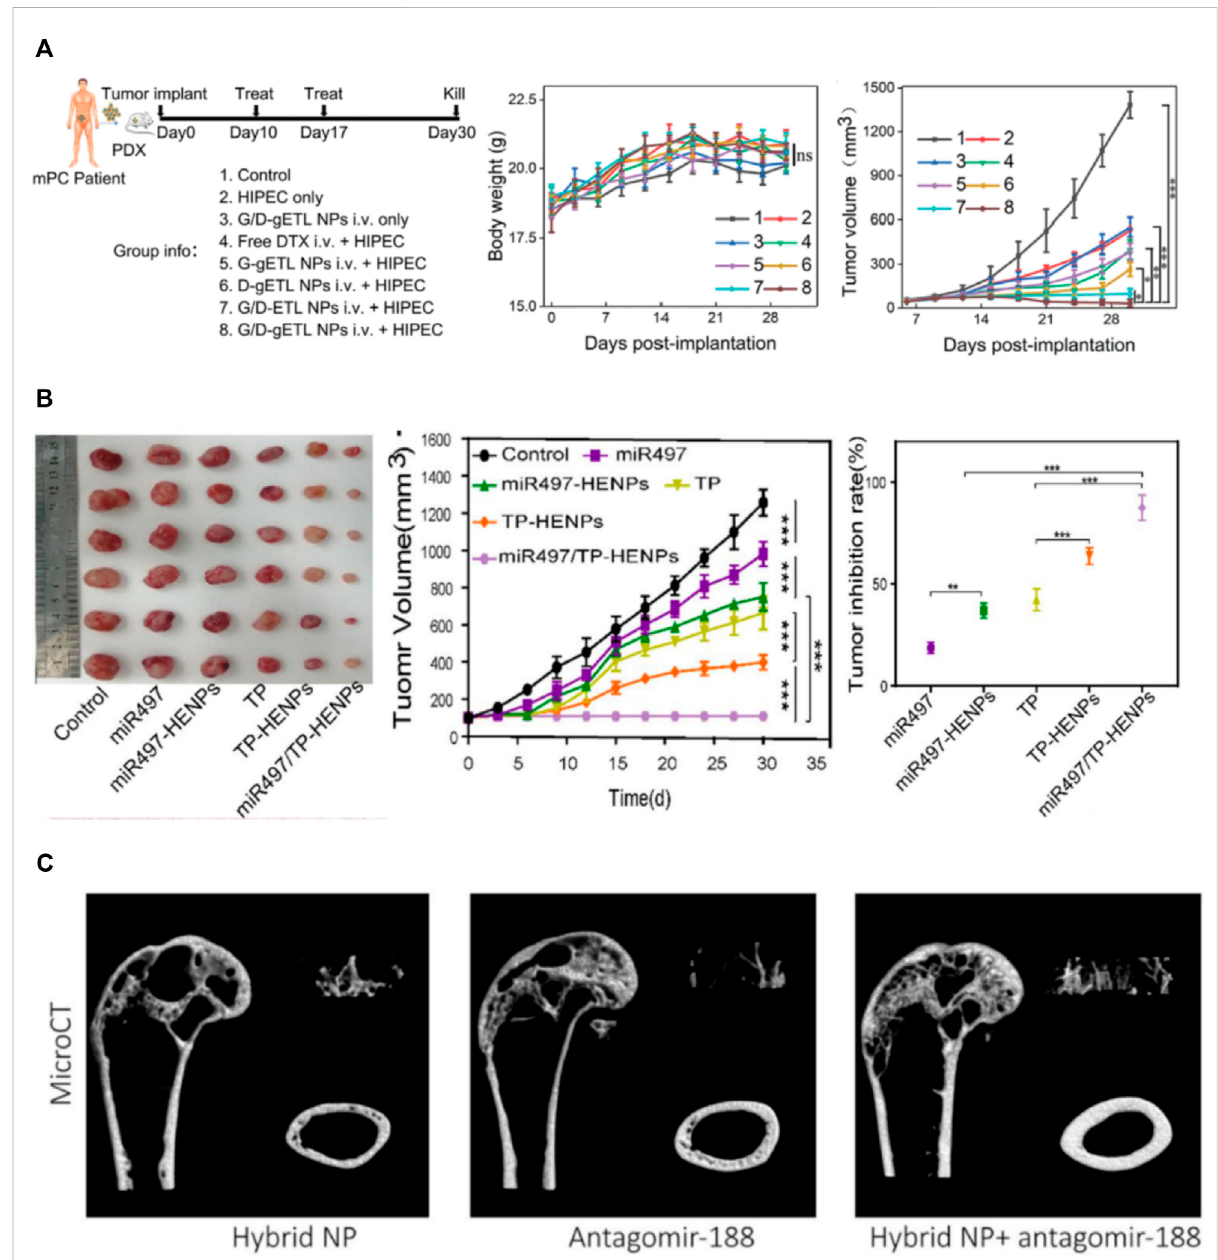
FIGURE 3 Applications of membrane fusion-based hybrid exosomes. (A) Characterization of the therapeutic bene fi ts of MFHE (G/D-gETL NPs) treatment in patient-derived mPC tumor xenografts (Lv et al., 2020) (B) The antitumor activity of MFHEs (miR497/TP-HENPs) in vivo (Li et al., 2022) (C) MFHEs carrying antagomir-188 are able to reverse aging-related bone loss (Hu et al.,